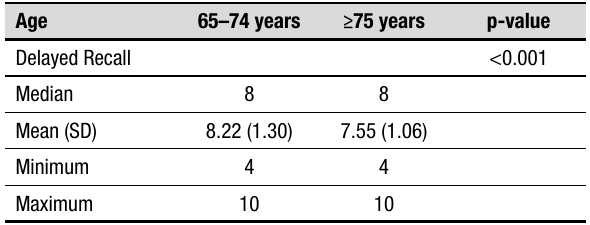
Table 1. Delayed recall of the Figure Memory Test of the Brief Cognitive Screening Battery according to